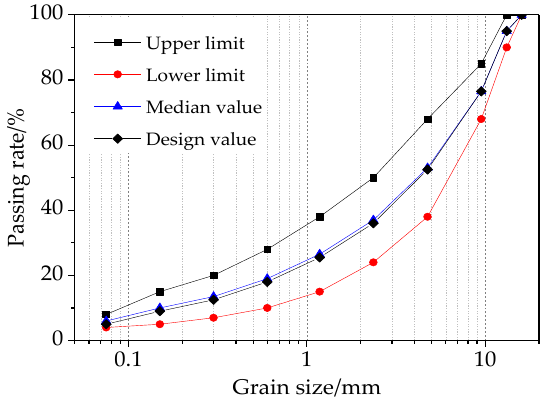
Figure 3. AC-13 mineral gradation curve.